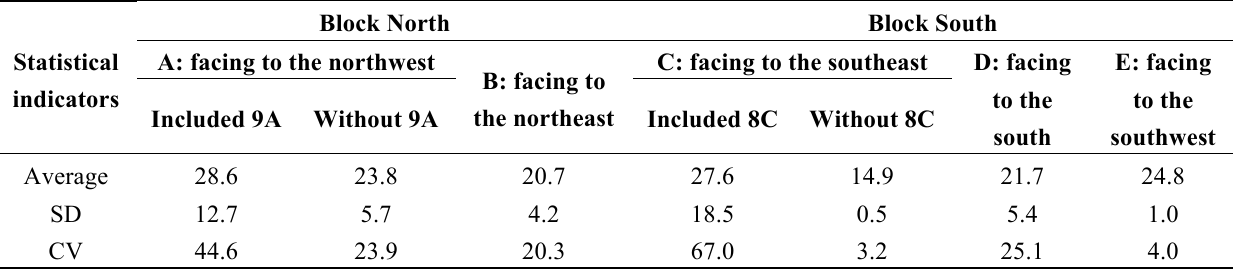
Table 6. Average and variability of historical natural gas consumption to heating during July according to orientation in kWh/m 2 . Period